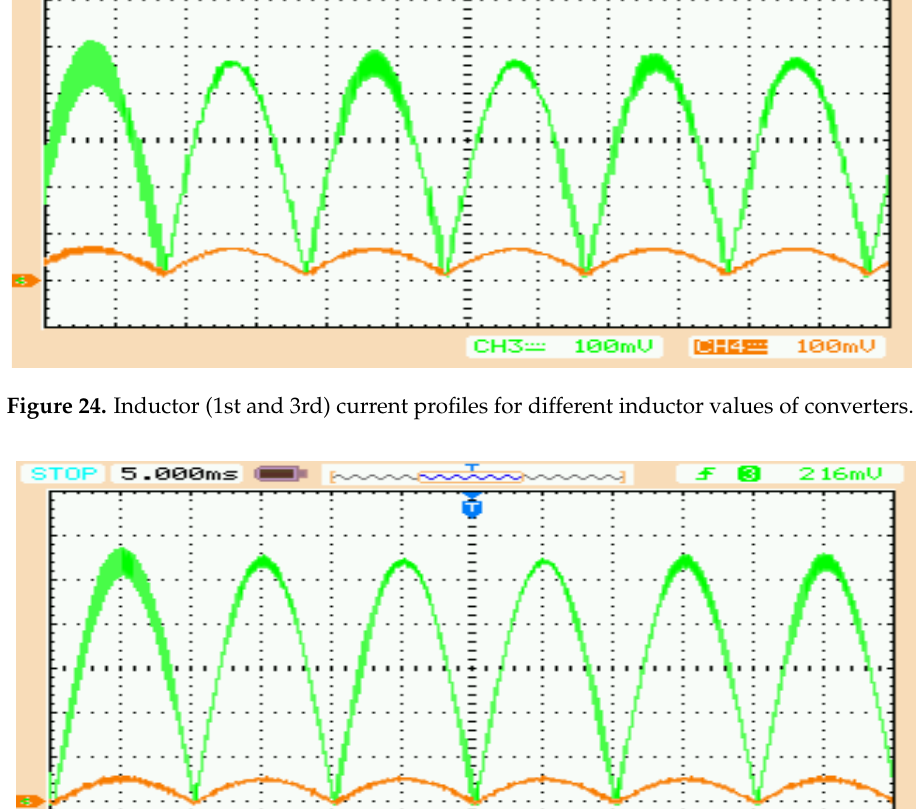
Figure 25. Inductor (2nd and 3rd) current profiles for different inductor values of converters.